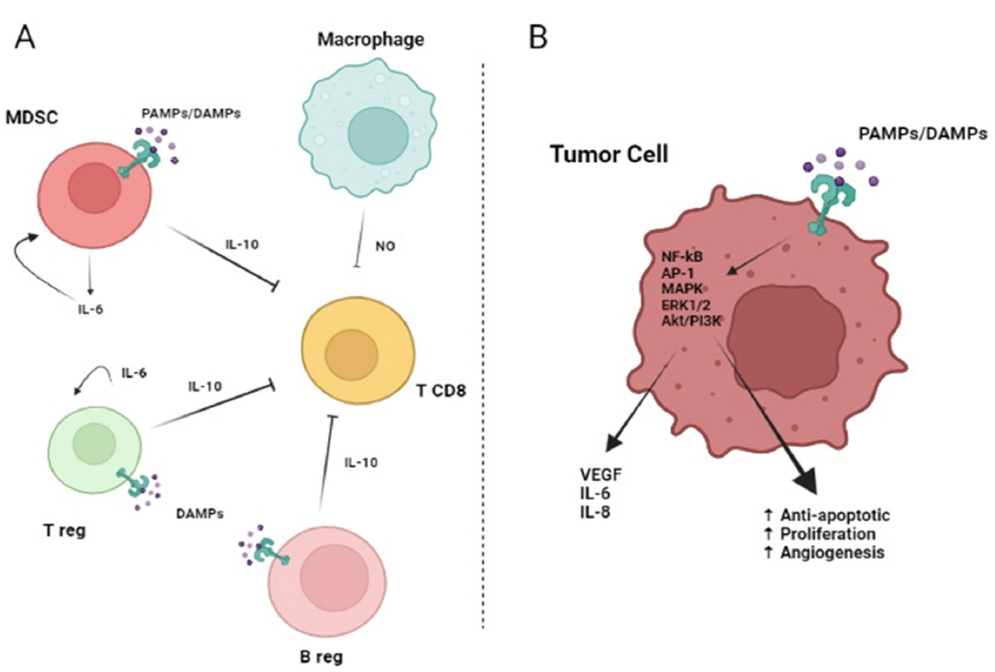
Figure 2. ( A ): TLR activation on myeloid-derived suppressor cells (MDSCs), B regulatory cells (Breg), and T regulatory cells (Treg) leads to an immunosuppressive effect. Indeed, MDSCs can induce macrophages to release nitric oxide (NO) that suppresses the activity of T CD8+ lymphocytes. Moreover, activated MDSCs, Bregs, and Tregs release IL-6 and IL-10 with a consequent synergic inhibitory effect on T CD8+ cells. ( B ): TLR expressed on tumor cells can bind DAMPs/PAMPs and activate intracellular signaling, such as nuclear factor kappa-light-chain-enhancer of activated B cells (NF-kB), AP-1, Akt/PI3K, extracellular signal-regulated kinase (ERK)1/2, and MAPK. The consequence is a pro-tumor effect due to the release of IL-6, IL-8, and VEGF and the promotion of proliferation, angiogenesis, and protection from apoptosis. Continuous arrows indicate activation or secretion. Created with BioRender.com (accessed on 4 May 2022).